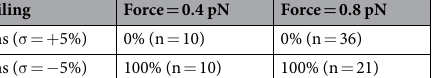
Supercoiling Force = 0.4 pN